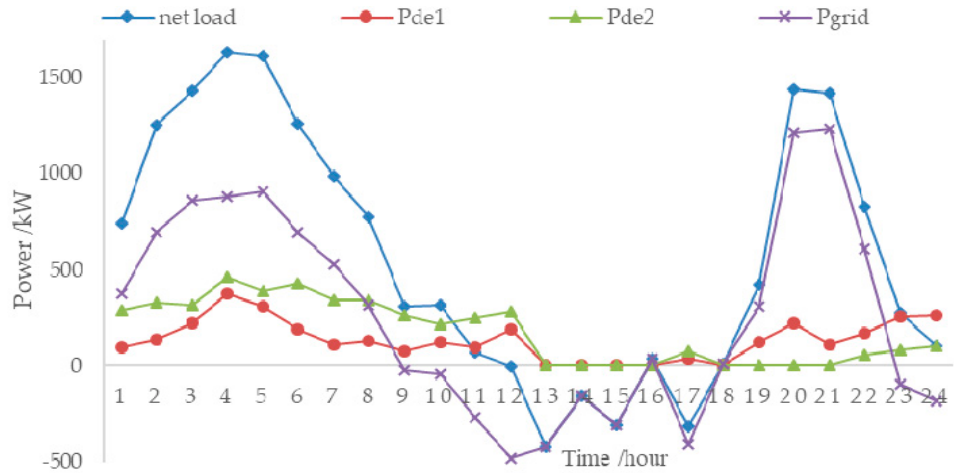
Figure 12. Output of each unit at the source-load-grid level.